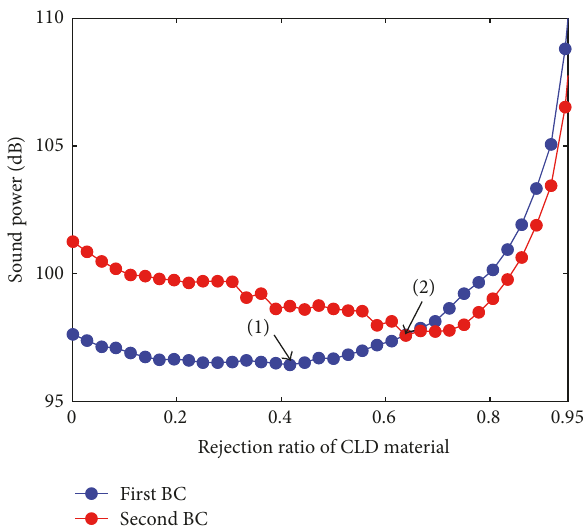
Figure 10: The relationship between sound power and rejection ratios of CLD materials obtained using ESO.